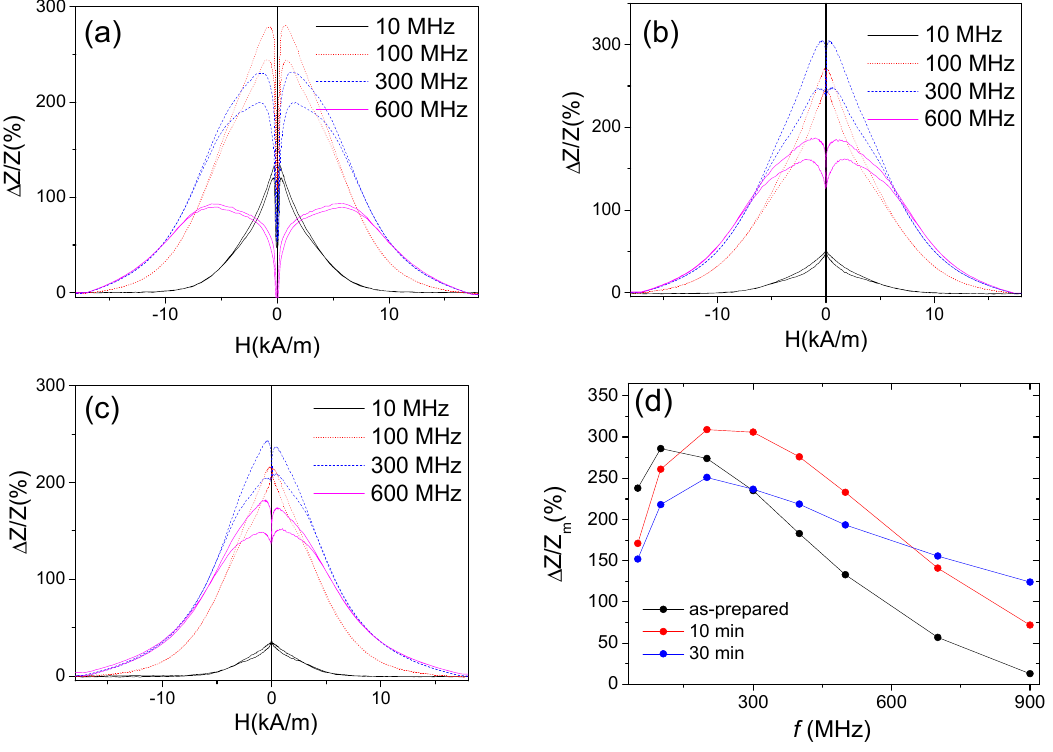
Figure 7. Δ Z/Z (H) dependencies of as-prepared ( a ); stress-annealed at T ann = 300 °C under σ a = 80 Figure 7. ∆ Z / Z (H) dependencies of as-prepared ( a ); stress-annealed at T ann = 300 ◦ C under σ a = MPa for 10 min ( b ); 30 min ( c ), and Δ Z/Z m (f) dependencies of as-prepared and stress-annealed 80 MPa for 10 min ( b ); 30 min ( c ), and ∆ Z / Z m (f) dependencies of as-prepared and stress-annealed Co 69.2 Fe 4.1 B 11.8 Si 13.8 C 1.1 microwires ( d ). Co 69.2 Fe 4.1 B 11.8 Si 13.8 C 1.1 microwires ( d